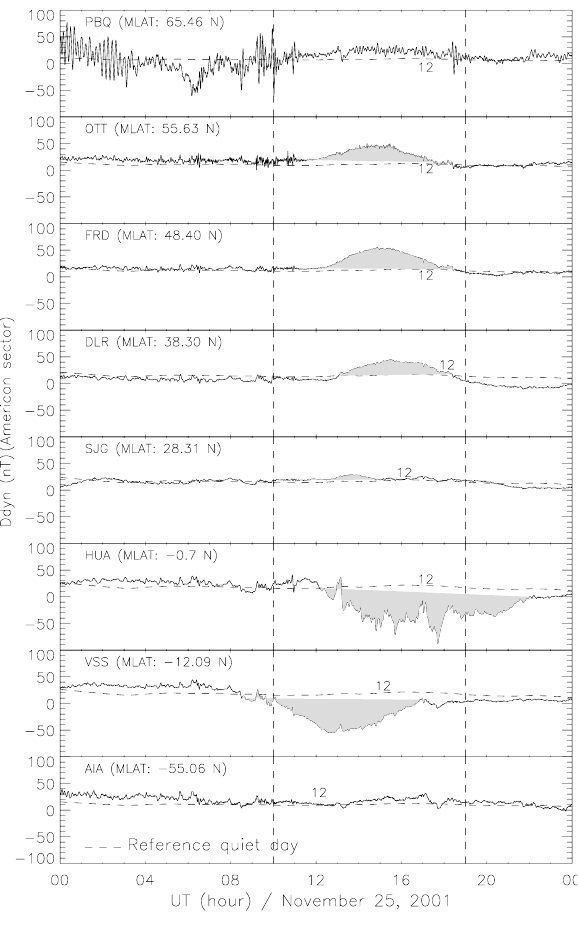
Fig. 9. Latitudinal variation of the Ddyn disturbance in the Ameri- can sector, on 1 April 2001.